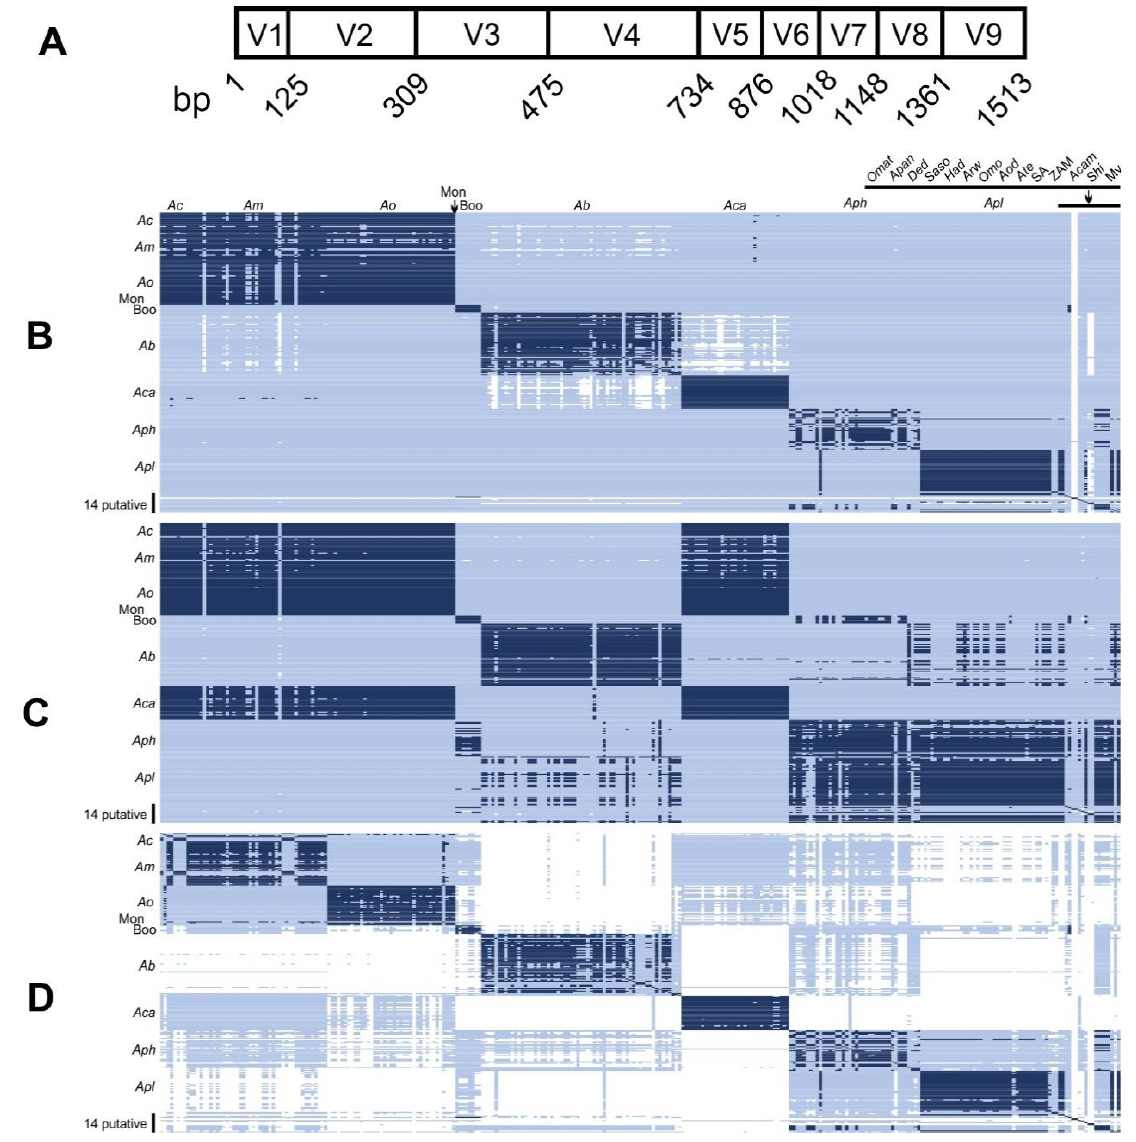
Figure 2. Comparisons of Anaplasma 16S rRNA sequences. ( A ) A map of the variable regions of 16S rRNA sequence A. marginale St. Maries strain. The start of each variable region was determined by the beginning of the conserved portion of the given variable region. Panels ( B – D ) are colorized representations of sequence identity matrices of regions of the 16SrRNA gene for known and putative Anaplasma species. ( B ) Comparison of the near-full-length (V2 – V9 regions) 16S rRNA sequence identity for 294 sequences of Anaplasma . ( C ) Comparison of the V3 – V4 regions of 16S rRNA sequence identity 294 Anaplasma sequences. ( D ) Comparison of concatenated V2 and V6 regions of 16S rRNA sequence identity 294 Anaplasma samples. In ( B – D ), each box represents a single 16S rRNA sequence of the indicated species of Anaplasma . Dark blue shading represents shared identity above or equal to 98.7% with white representing shared identity below 95%. Light blue shading represents identities between 95 – 98.7%. Coding is as follows: Ac: A. centrale ; Am: A. mar-